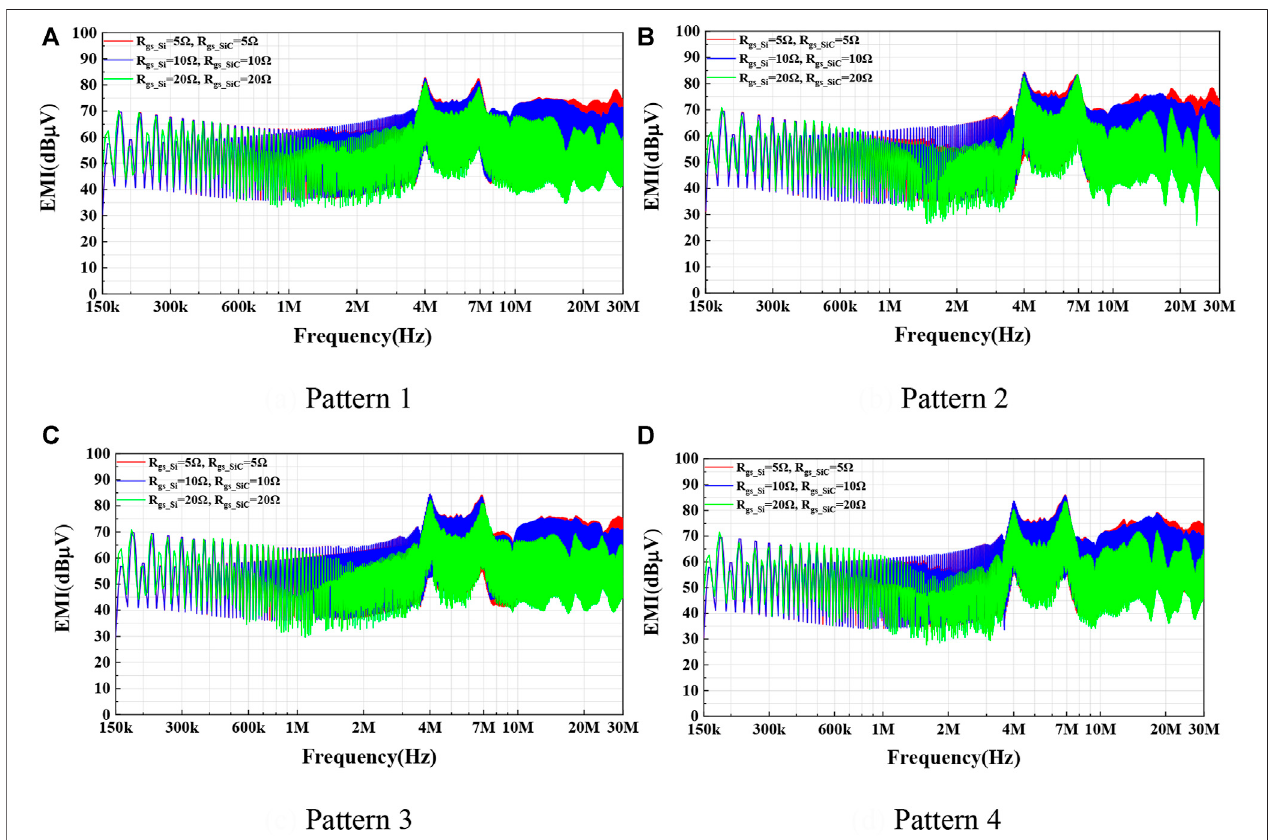
FIGURE 13 | Relationship between the gate resistor and CM EMI noise (all gate resistors are changed simultaneously). (A) Pattern 1, (B) pattern 2, (C) pattern 3, and (D) pattern 4.